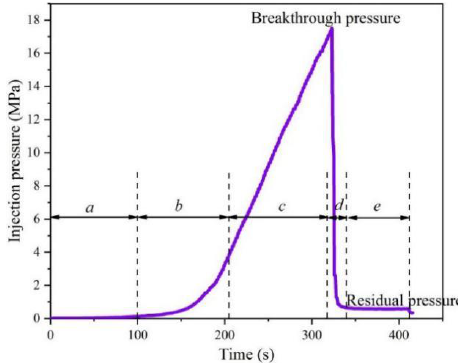
Figure 10. Typical pressure-time curve of Indosinian granite in the fracturing experiments.